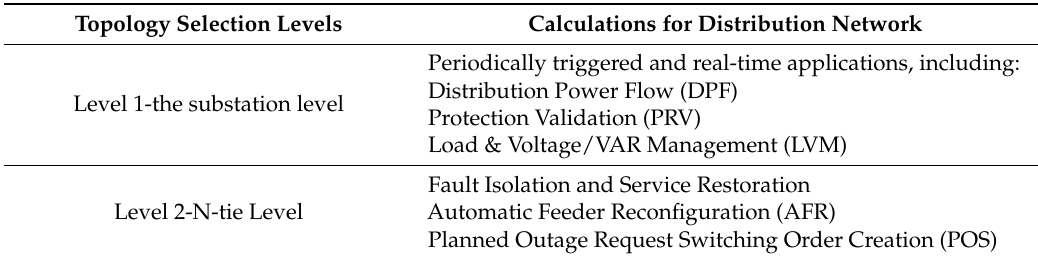
Table 1. Network topology selection levels with respect to various applications of